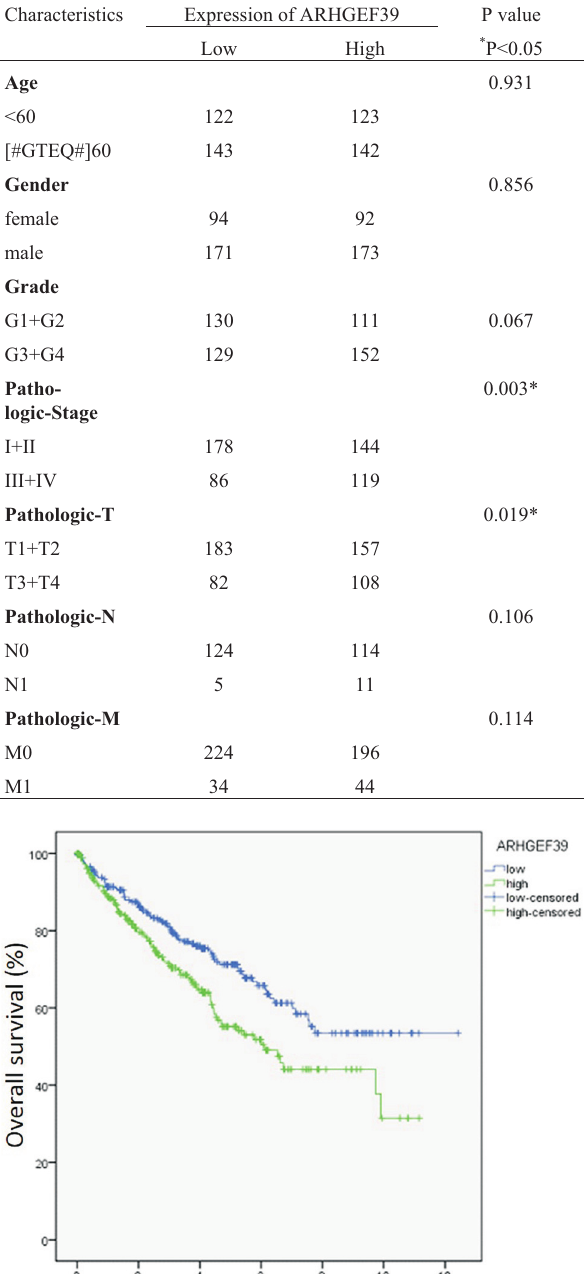
Table 1 - Correlation between ARHGEF39 expression and clinicopa- thological characteristics of ccRCC patients from TCGA database. Characteristics